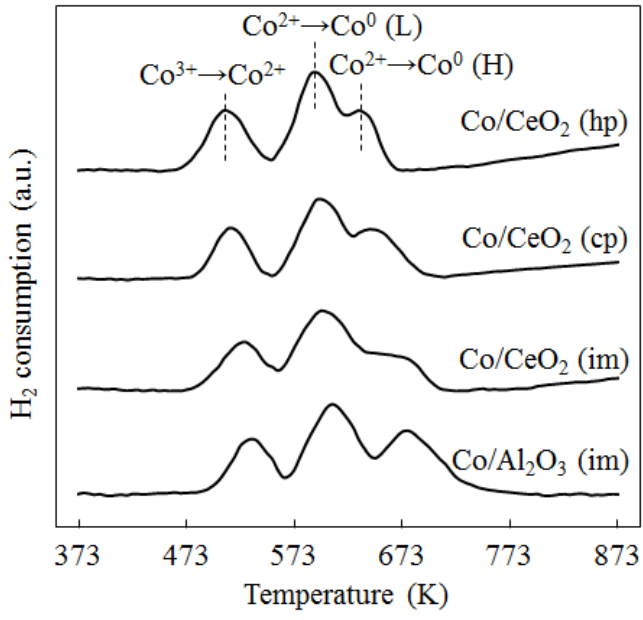
Figure 3. H 2 -TPR profiles of various Co-based samples after calcination at 723 K for 3 h.